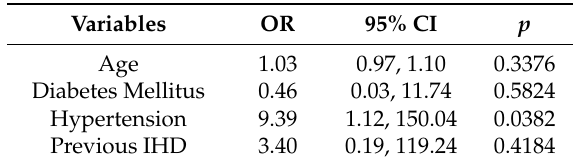
Table 3. Adjusted odds ratio (OR) and CI of confounding factors.